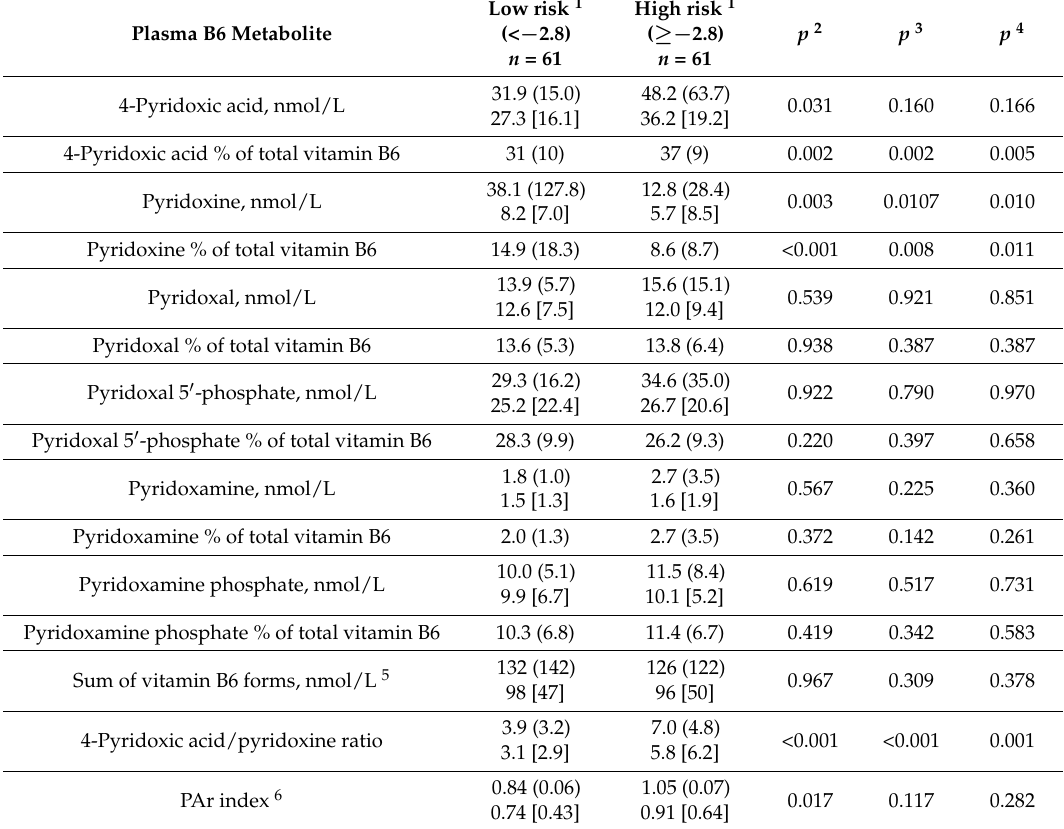
Table 2. Concentrations of plasma vitamin B6 forms according to the risk score of cardiovascular hospitalization in 122 patients with type 2